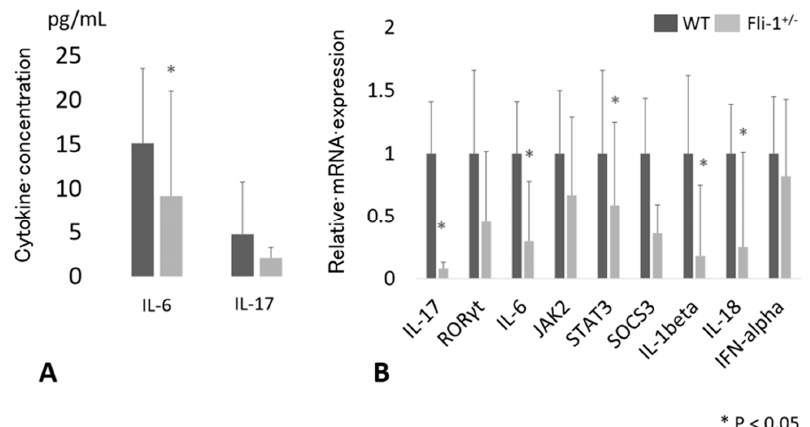
Figure 1. Serum cytokine levels and renal mRNA expression related to interleukin (IL)-6 and IL-17A cytokine signaling. ( A ) Serum IL-6 and IL-17A concentrations (pg/mL) in adult (4 to 10 months